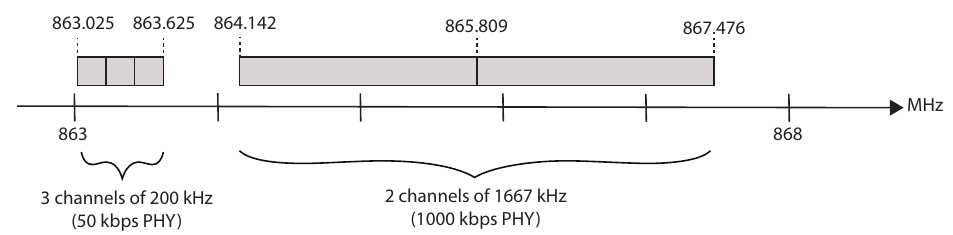
Figure 8. The channel allocation for the 50kbps and 1000kbps PHYs in the 863–868MHz band, as used in the evaluation. The former uses 3 channels of 200kHz while the latter uses 2 channels of